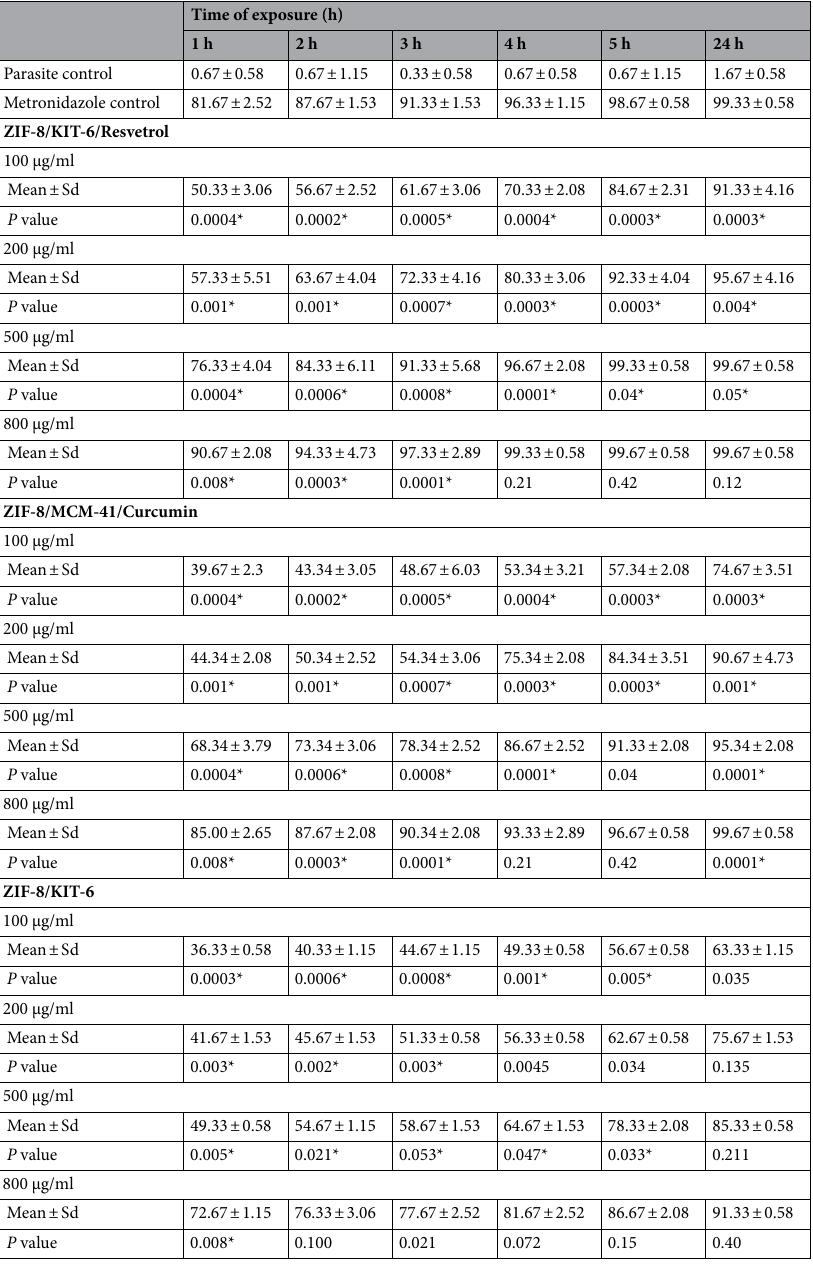
Table 2. Reduction in the percentage of viability of blastocystosis cysts in parasite control group (negative control), after exposure to metronidazole (positive control), and after exposure to the three nanocomposites. Data are presented as the mean ± standard deviation (SD), * P < 0.05 is statistically significant, compared to the parasite